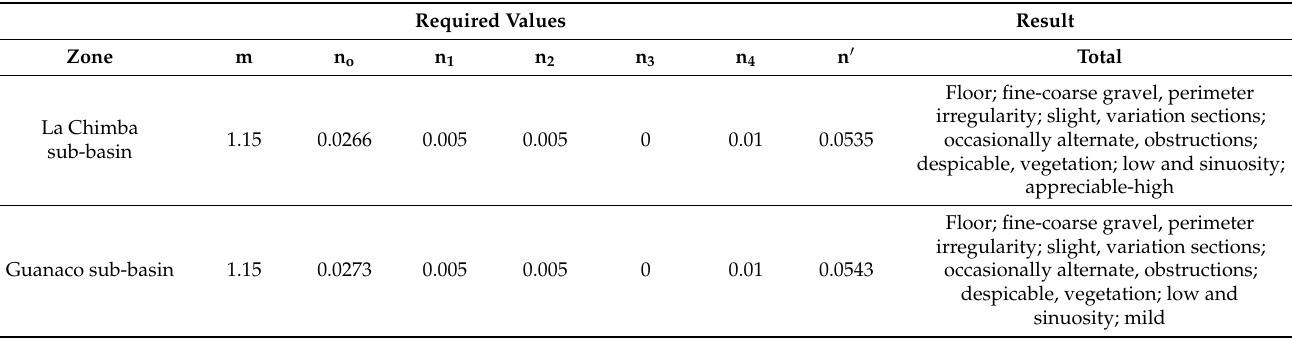
Table 9. Value of the Manning roughness coefficient sub-indices—the Cowan method. In addition, the value of the volume of the debris flow ( V d ) is considered with a value of 367,647 m 3 and an average velocity ( V m ) of 3.03 m/s for the maximum intensity of rainfall in a hydrograph time of 1.5 h. Required